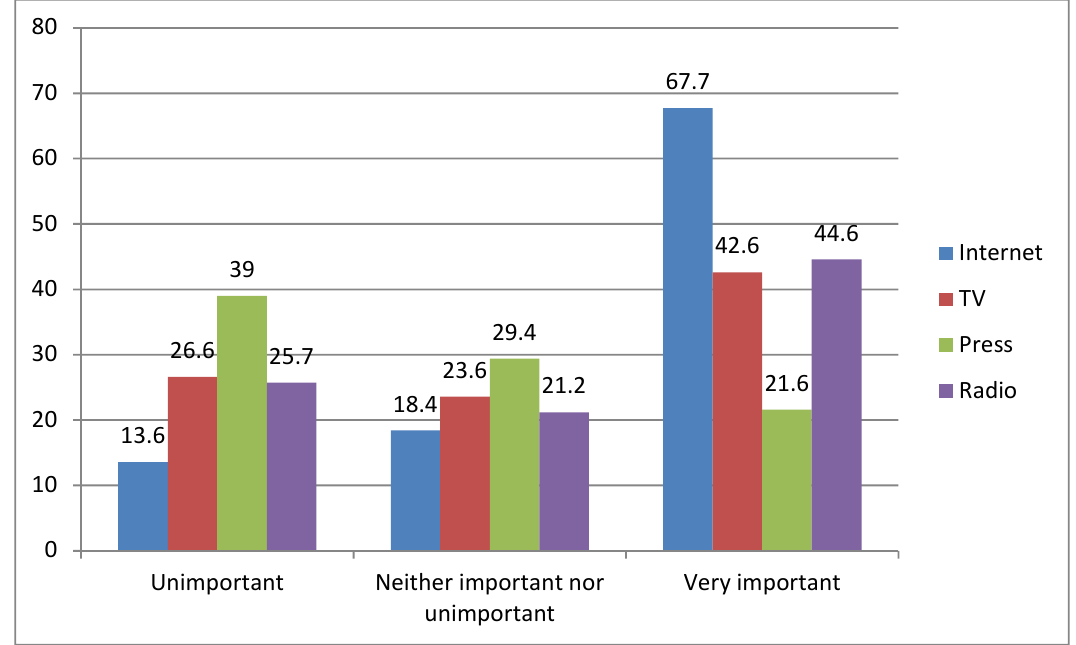
Importance of media as an entertainment